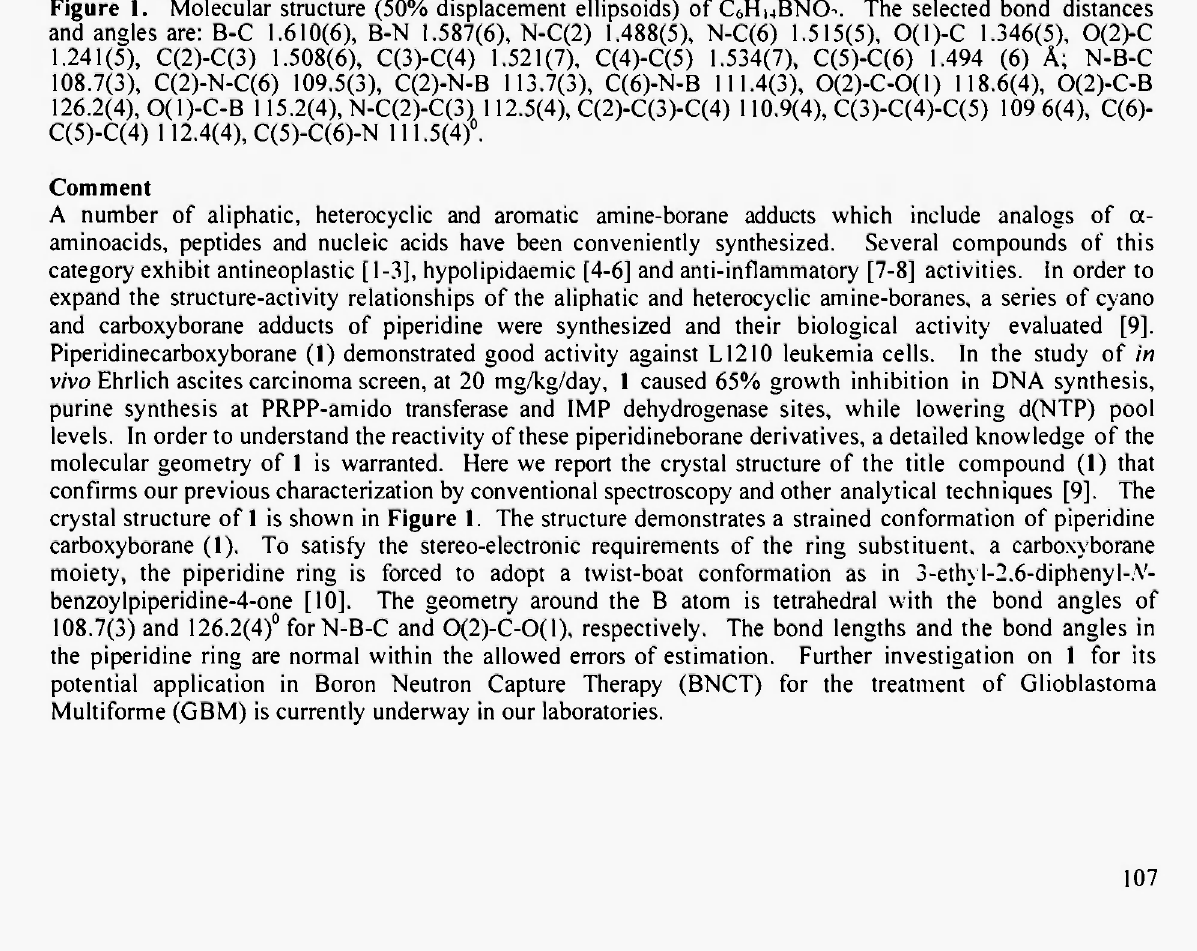
Figure 1. Molecular structure (50% displacement ellipsoids) of C 6 H u B N (X The selected bond distances and angles are: B-C 1.610(6), B-N 1.587(6), N-C(2) 1.488(5), N-C(6) 1.515(5), 0(1)-C 1.346(5),